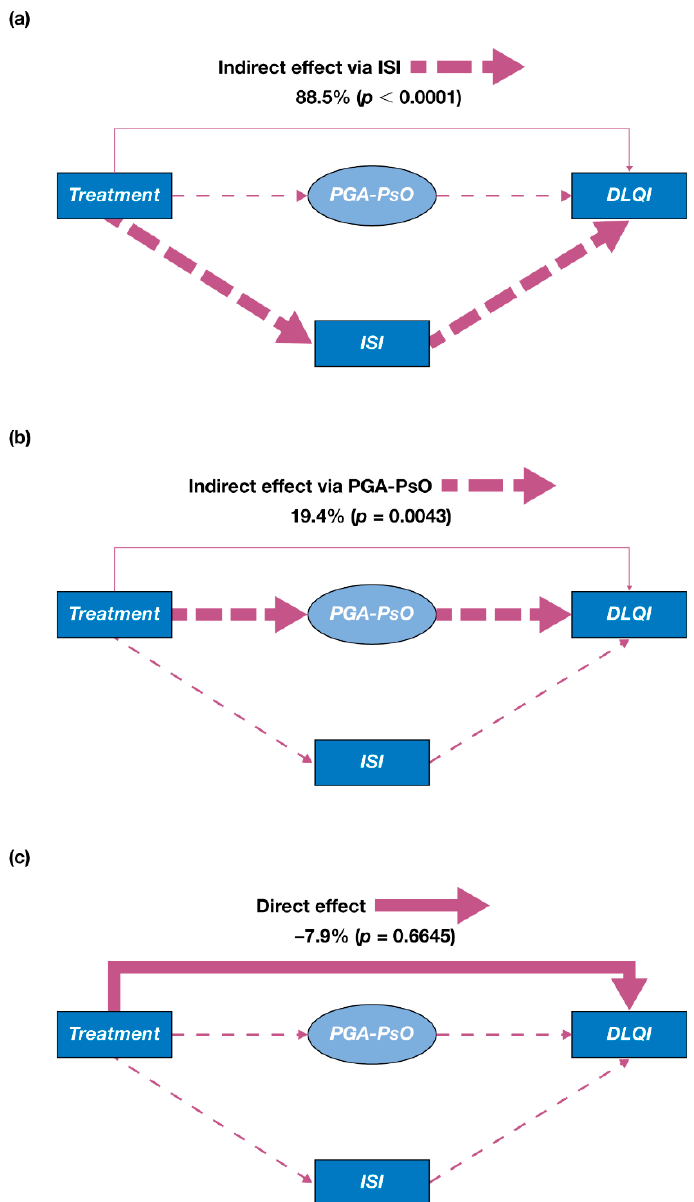
Figure 2. Effects of tofacitinib treatment on DLQI in the initial mediation model (pooled data from OPAL Broaden and OPAL Beyond). ( a ) Indirect effect via itch (measured by ISI); ( b ) indirect effect via PGA-PsO; ( c ) direct effect. Treatment was represented by a binary variable (tofacitinib 5 mg twice daily [value of 1] versus placebo [value of 0]); the model included mean scores of each outcome from Months 1 and 3 for every patient with available data from OPAL Broaden or OPAL Beyond; PGA-PsO was a latent variable represented by means of erythema, induration, and scaling.